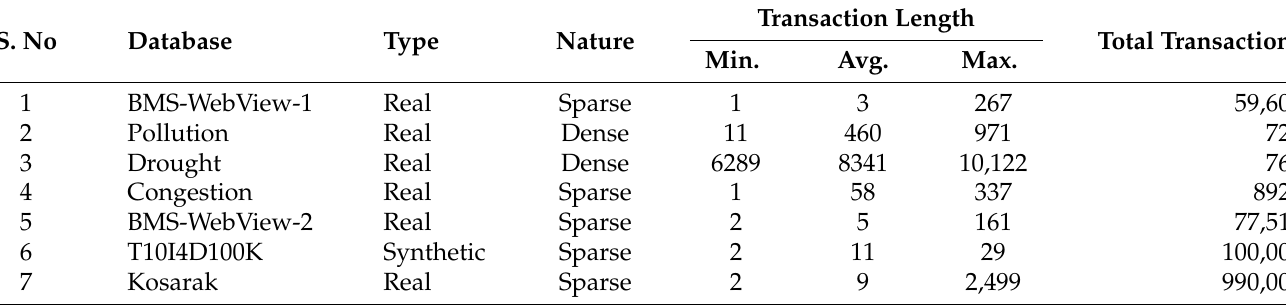
Table 4. Statistics of the